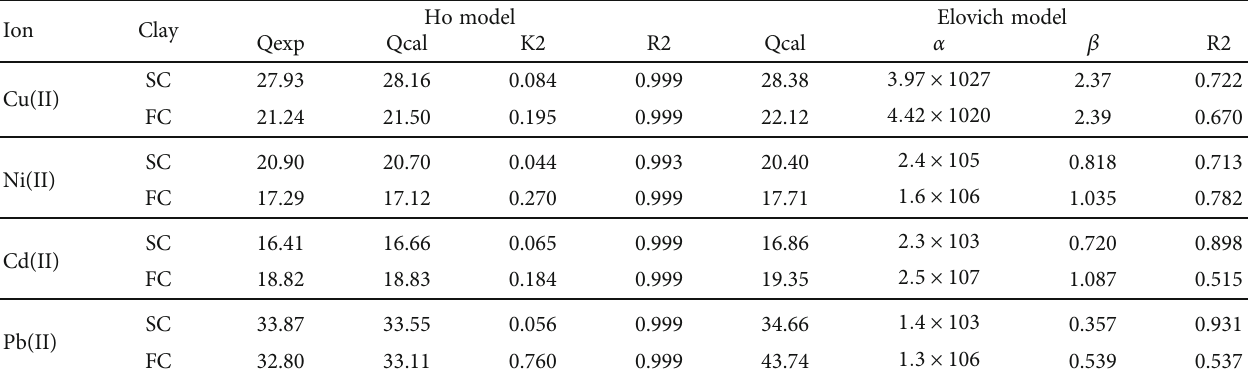
Table 4: Parameters of kinetic models for adsorption of Cu(II), Ni(II), Cd(II), and Pb(II) in clays: sodium (SC) and ferric